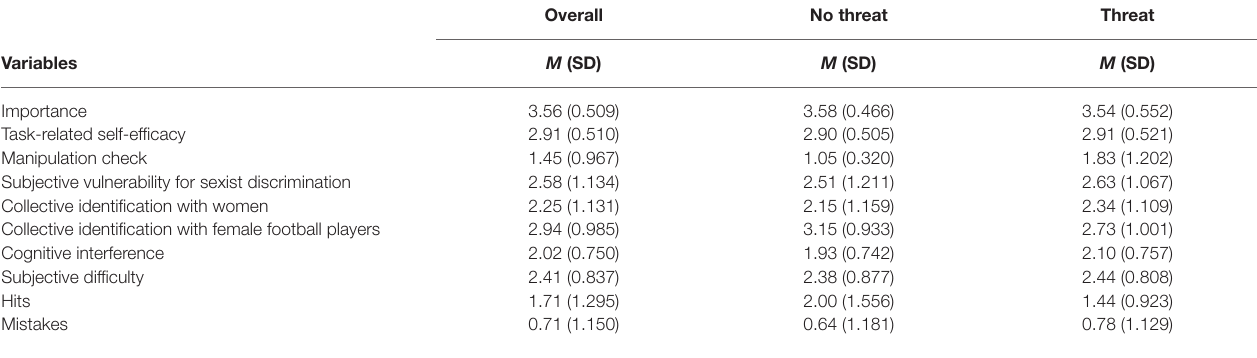
TABLE 1 | Means and standard